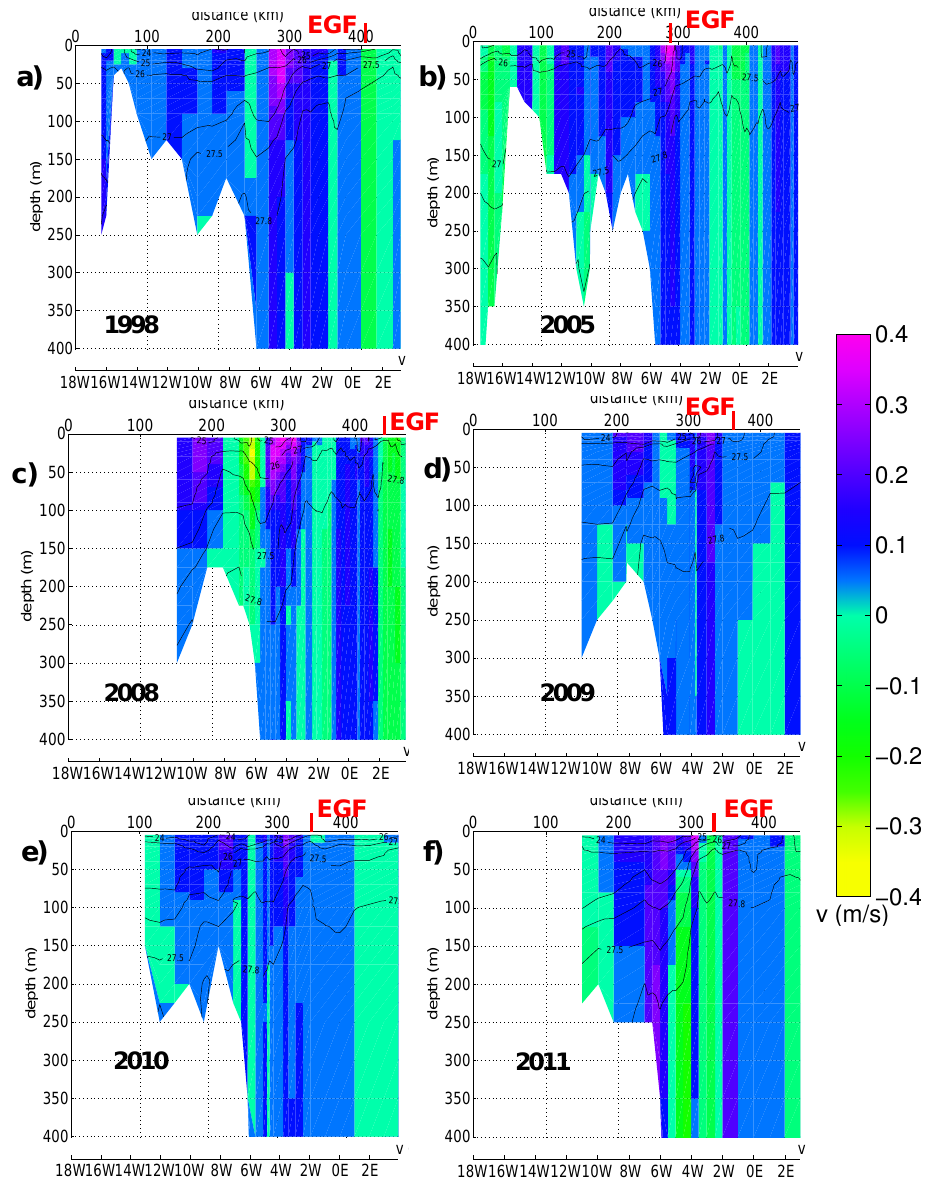
Fig. 2. Meridional velocity sections along the Western Fram Strait from the inverse solution: (a) 1998, (b) 2005, (c) 2008, (d) 2009, (e) 2010 and (f) 2011. Velocity is positive southward. Contours represent potential density from the inverse solution. Potential density is given in σ notation, as departures from 1000kgm − 3 . The position of the East Greenland Front, here defined as the westernmost surface outcrop of the zero isotherm, is marked by the thick vertical line next to